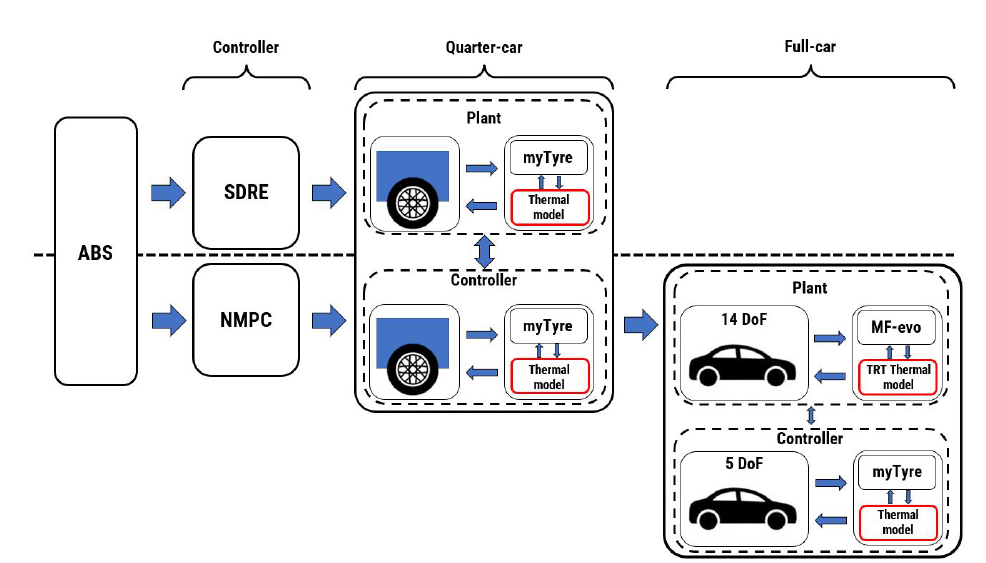
Figure 1. ABS controller development